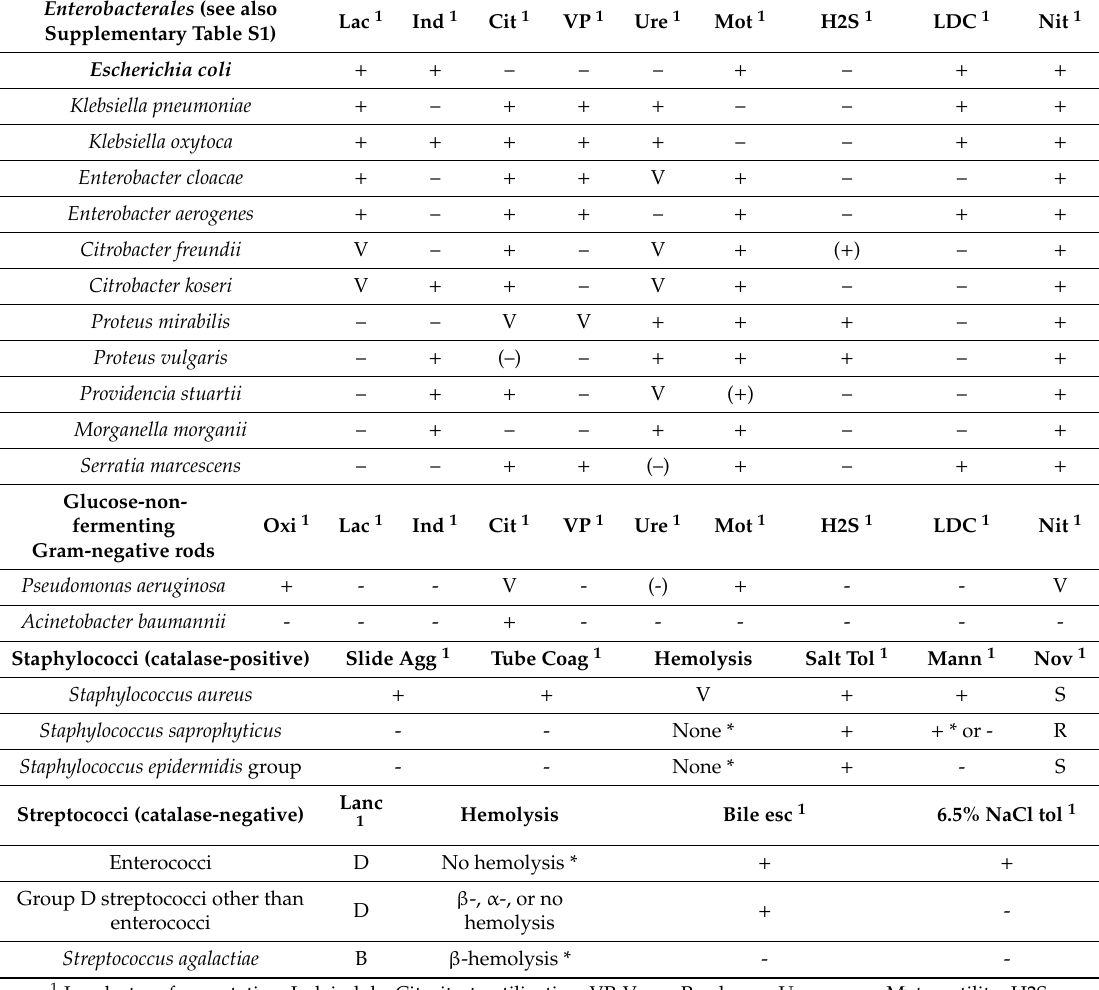
Table 3. Advanced biochemical identification of common